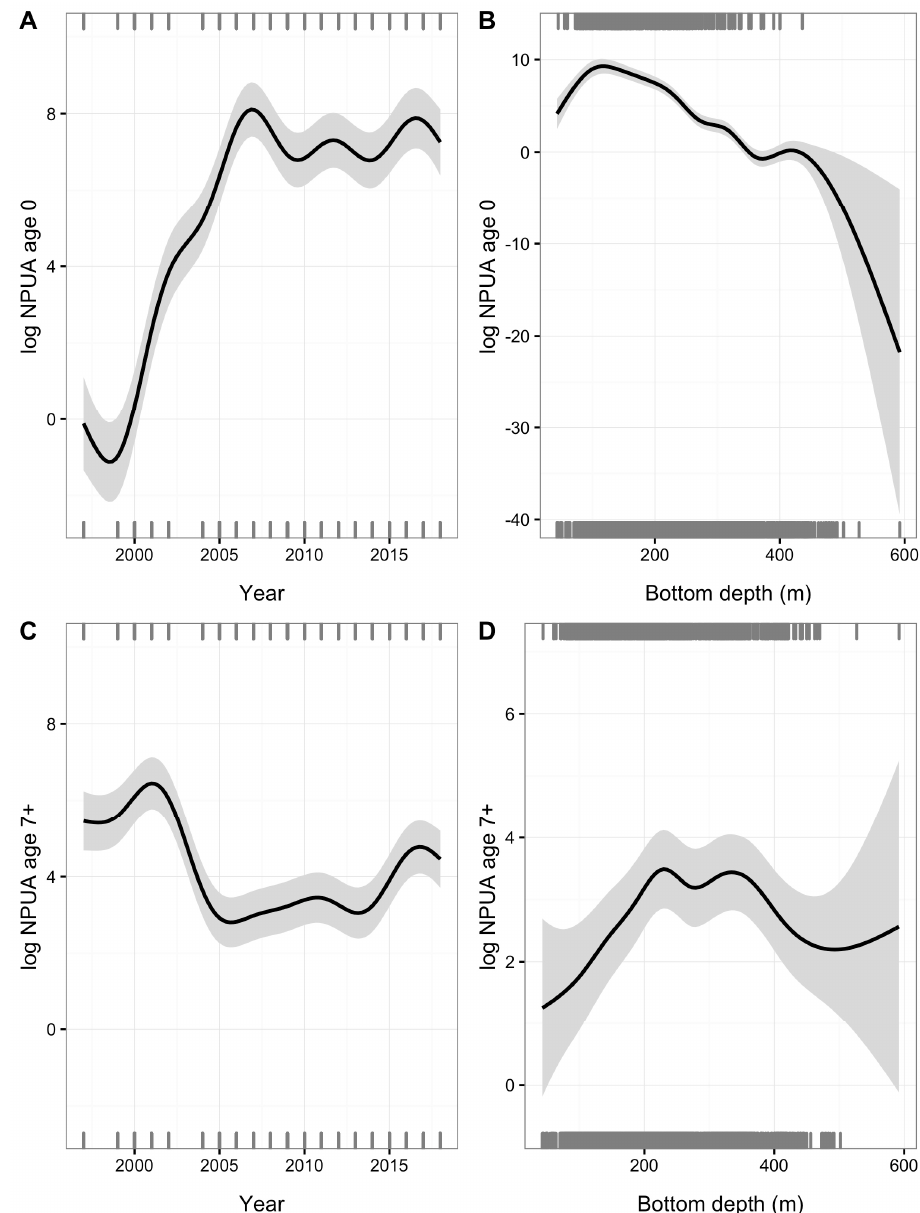
Figure 8. Temporal changes in log abundance and distribution of the abundance as a function of the bottom depth: log abundance of age 0 ( A , B ), and log abundance of age 7+ ( C , D ).